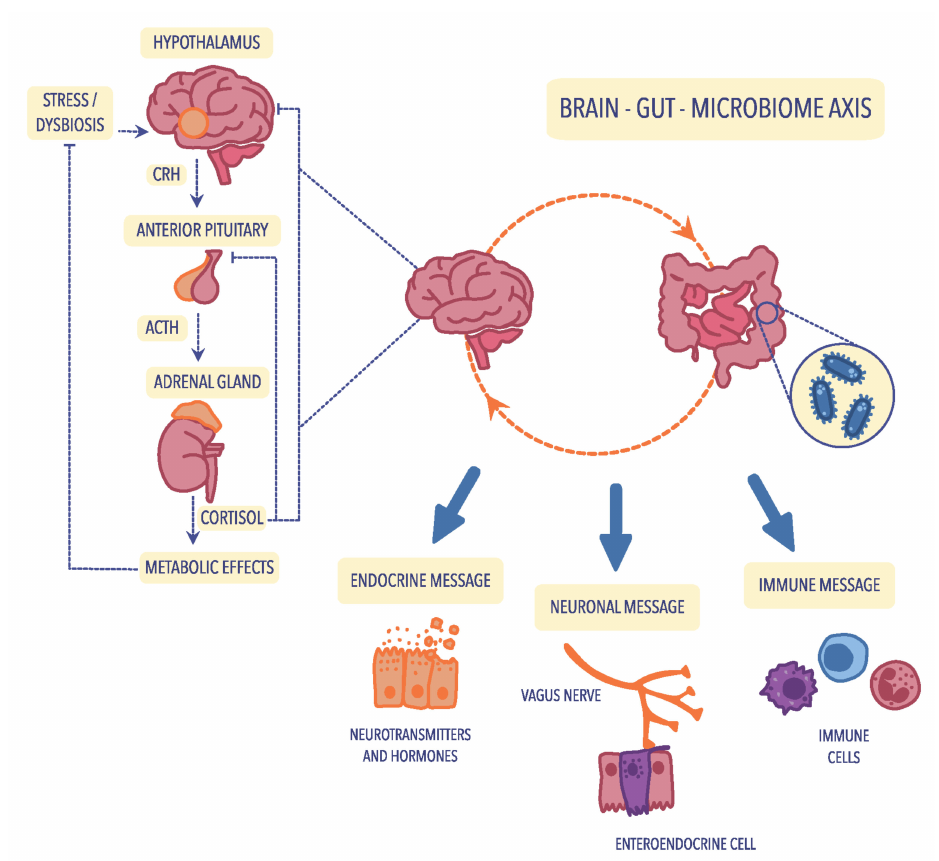
Figure 1. The bidirectional communication of the microbiota–gut–brain axis is mediated by the immune, neuroendocrine, and neuronal pathways. The activation of the hypothalamic–pituitary– adrenal (HPA) axis is associated with the occurrence of stress factors or dysbiosis, which increase the release of corticotropin-releasing hormone (CRH) from the hypothalamus, which subsequently stimulates the transport of adrenocorticotropic hormone (ACTH) from the anterior pituitary. Under the influence of ACTH, the adrenal gland begins to produce and secrete the stress hormone (cortisol), which is responsible for the modulation of intestinal immune and barrier functions. Figure was created using the Vectornator